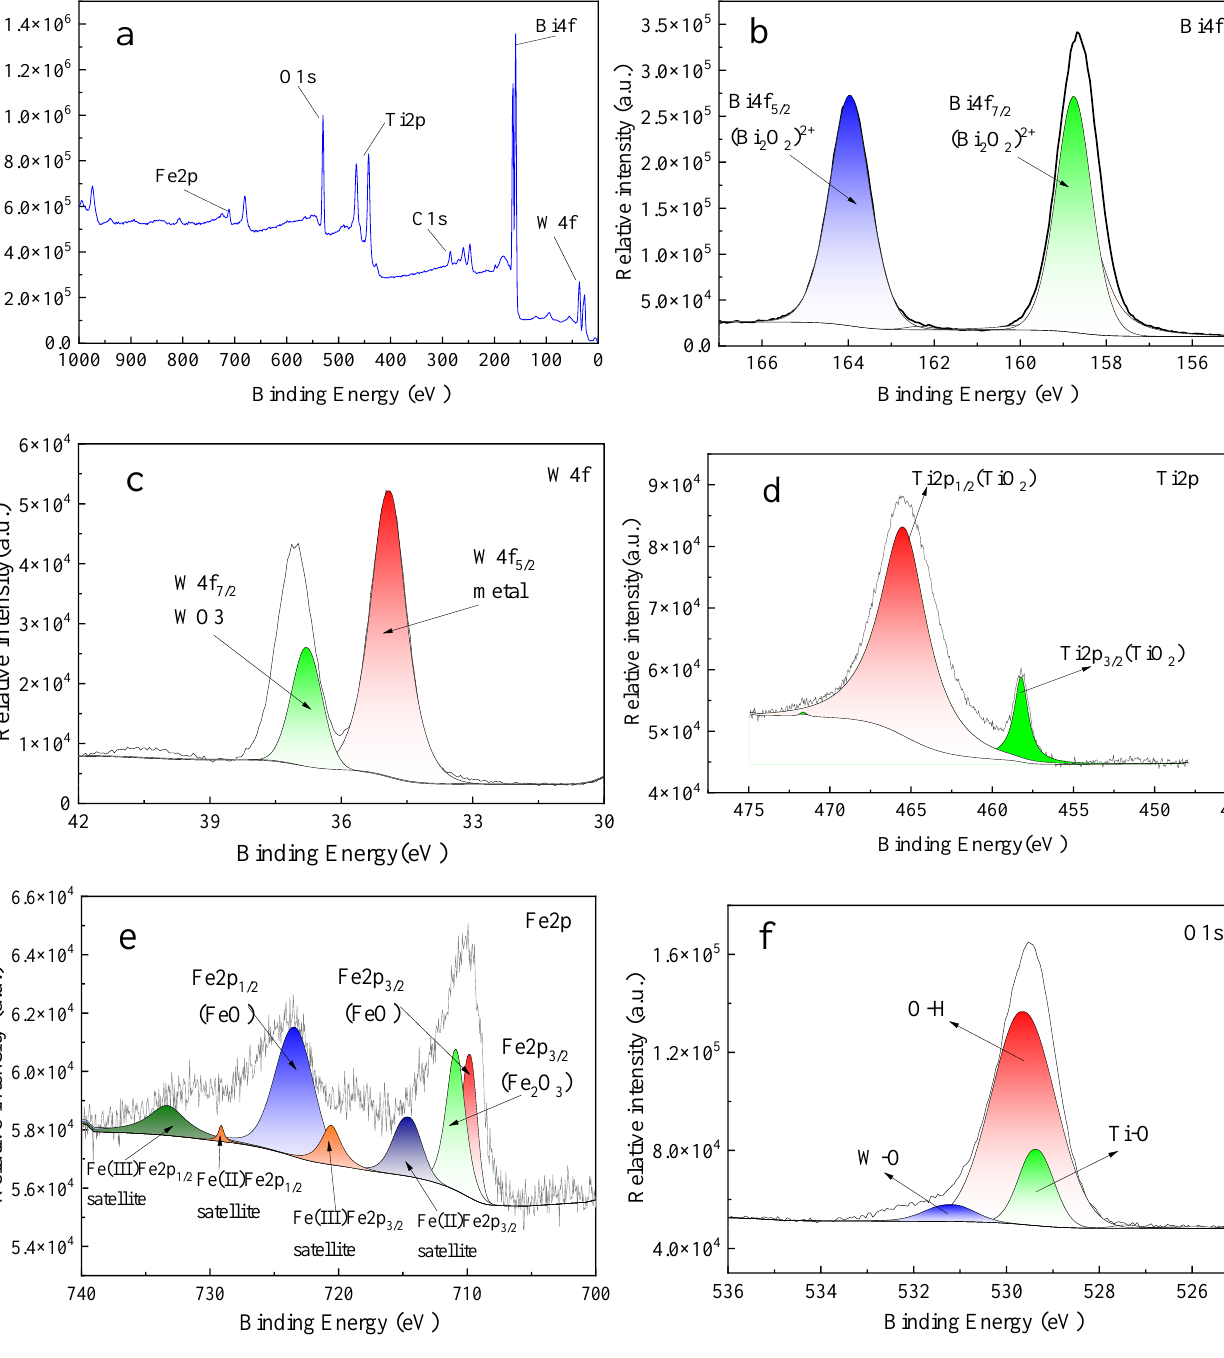
Figure 3. XPS total spectrum image of mBT ( a ) and the special spectrum of Bi4f ( b ), W4f ( c ), Ti2p ( d ), Fe2p ( e ), and O1s ( f ).